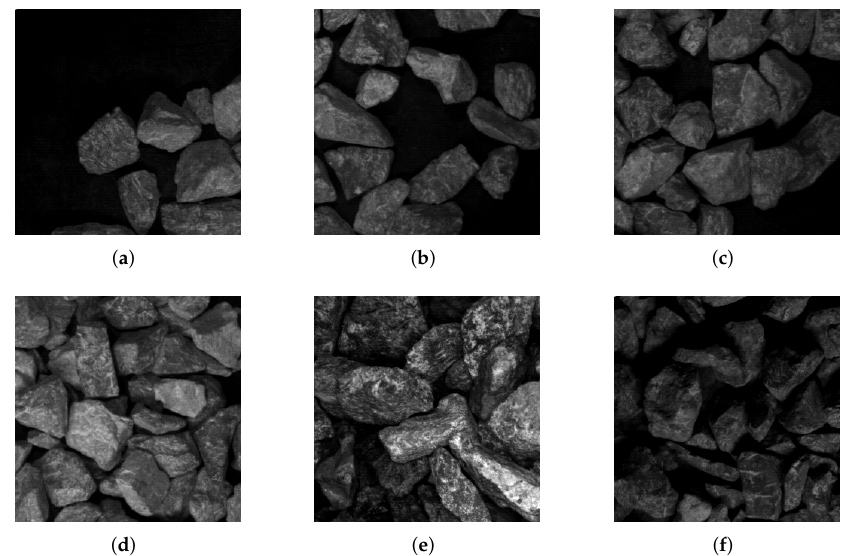
Figure 7. ( a – d ) depict ore images with varying densities under the same light. ( e ) is a different type of ore image with a smaller ore volume. ( f ) depicts the ore image in low